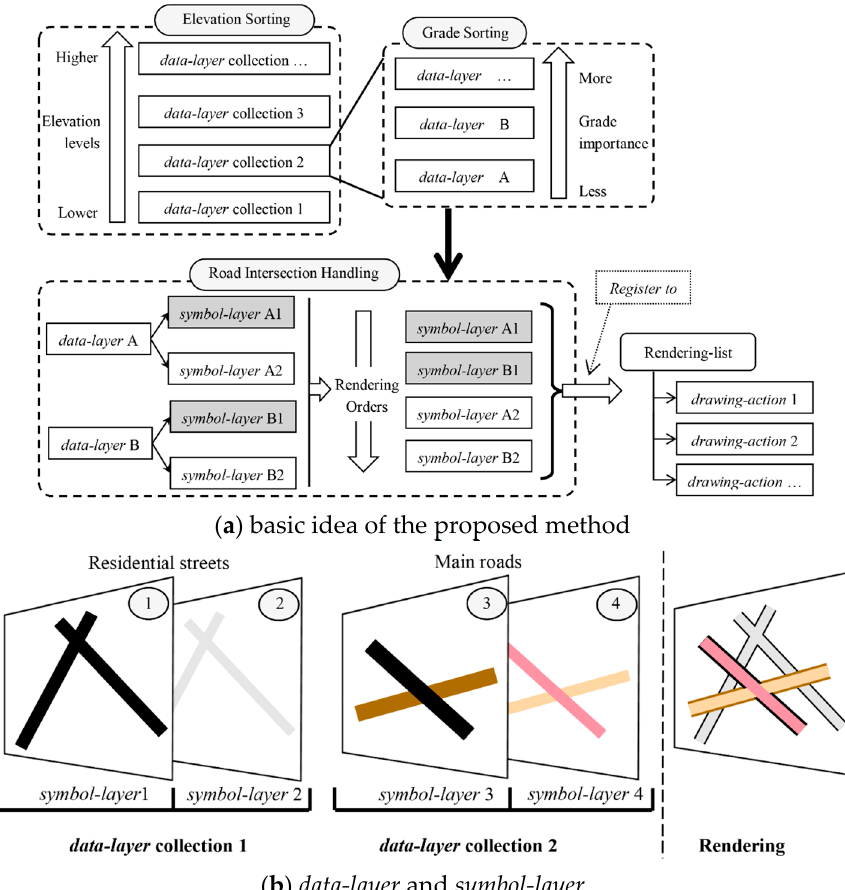
Figure 3. Basic process of building the rendering list.